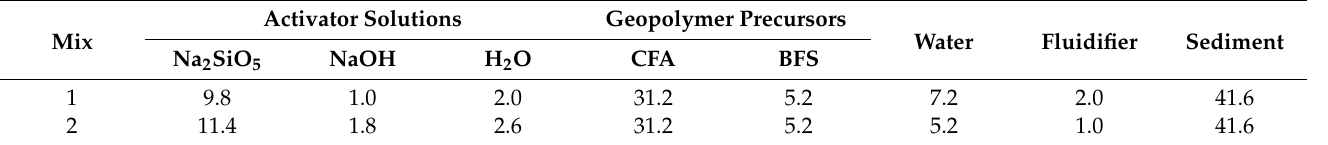
Table 1. Mixture design for S/S treatment (values in dry weight